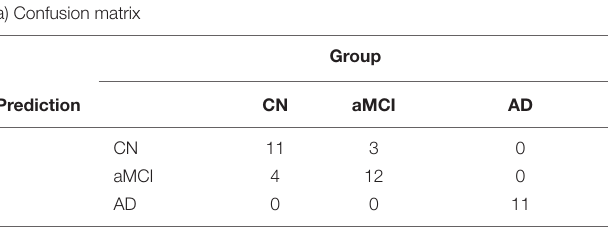
TABLE 5 | Prediction model using the discriminant model for classifying the individuals into the group accurately a) confusion matrix b) sensitivity, specificity, positive predictive value (PPV), and negative predictive value